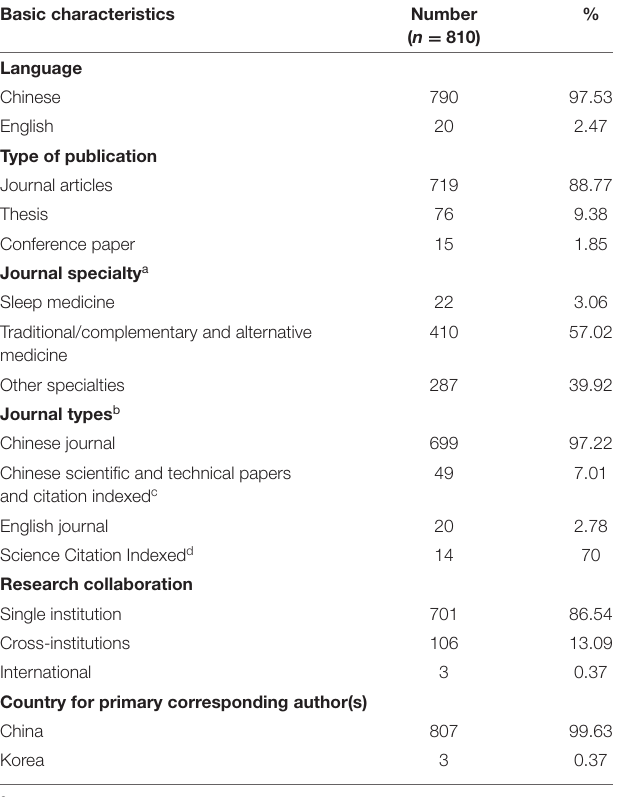
TABLE 1 | Basic characteristics of the source of